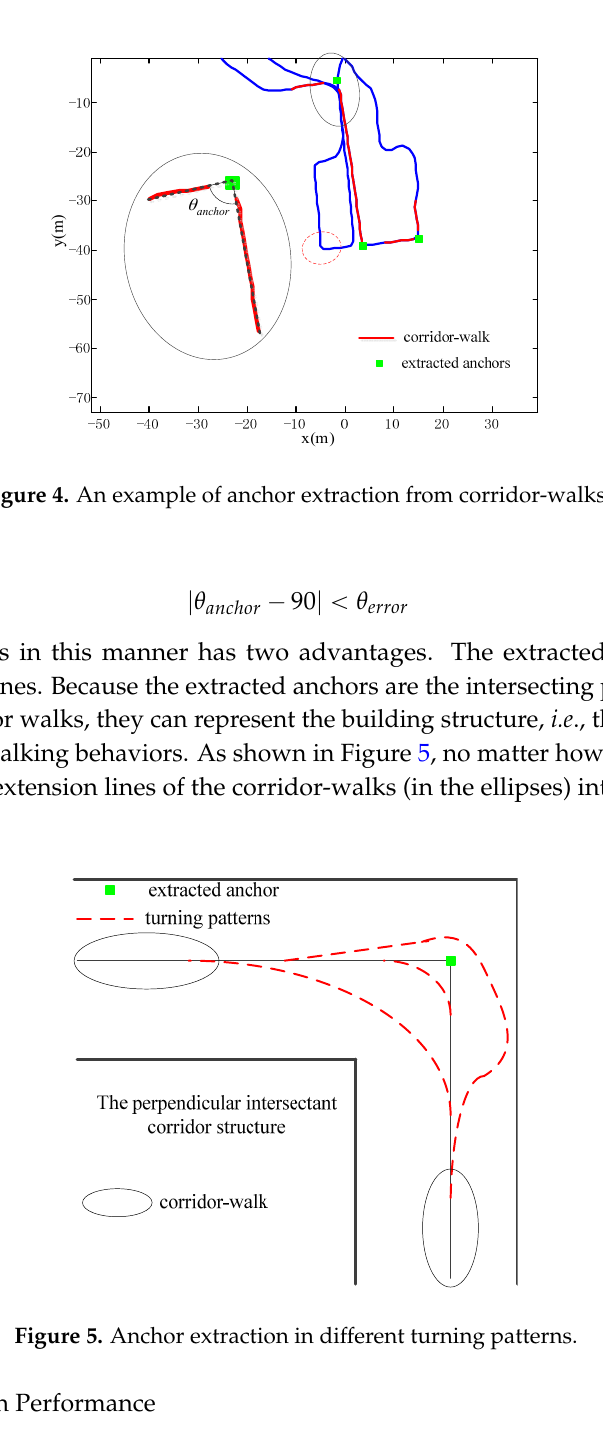
Figure 5. Anchor extraction in different turning patterns.